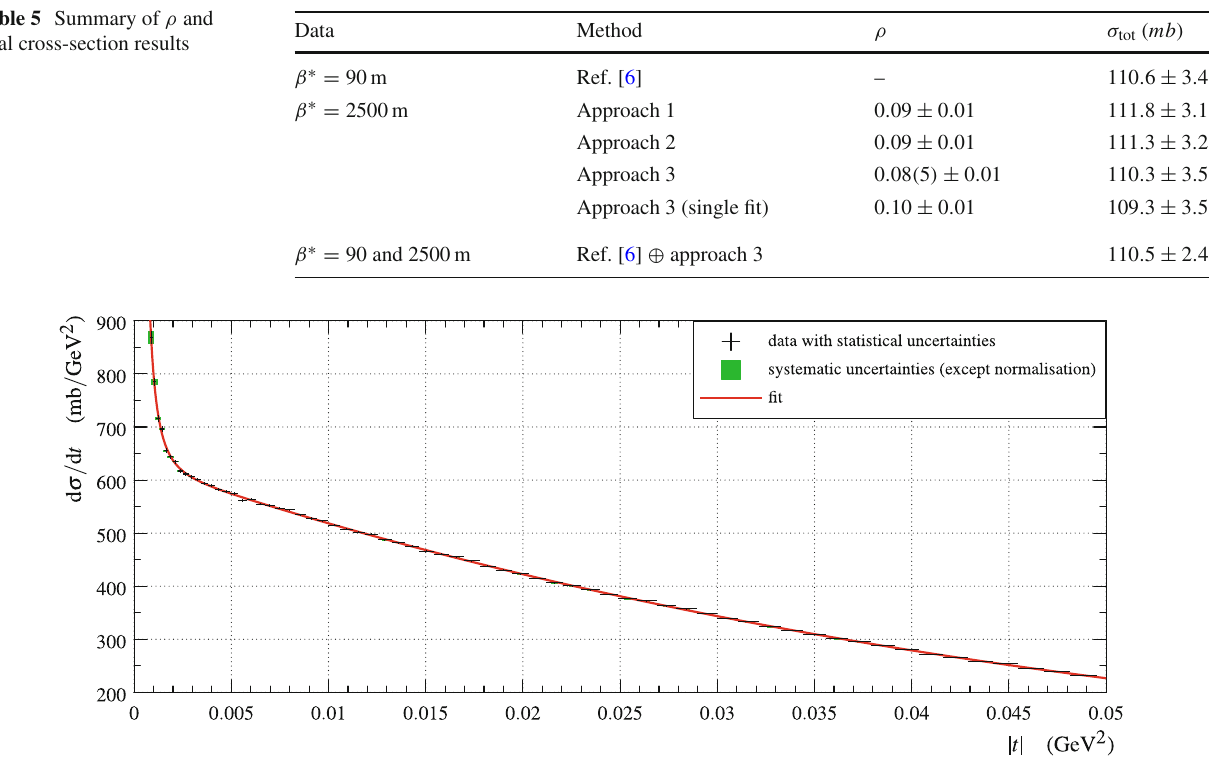
Fig. 18 Illustration of approach 3, single fit. The data come from Table 3, the normalisation uncertainty is not shown as it is not relevant for this